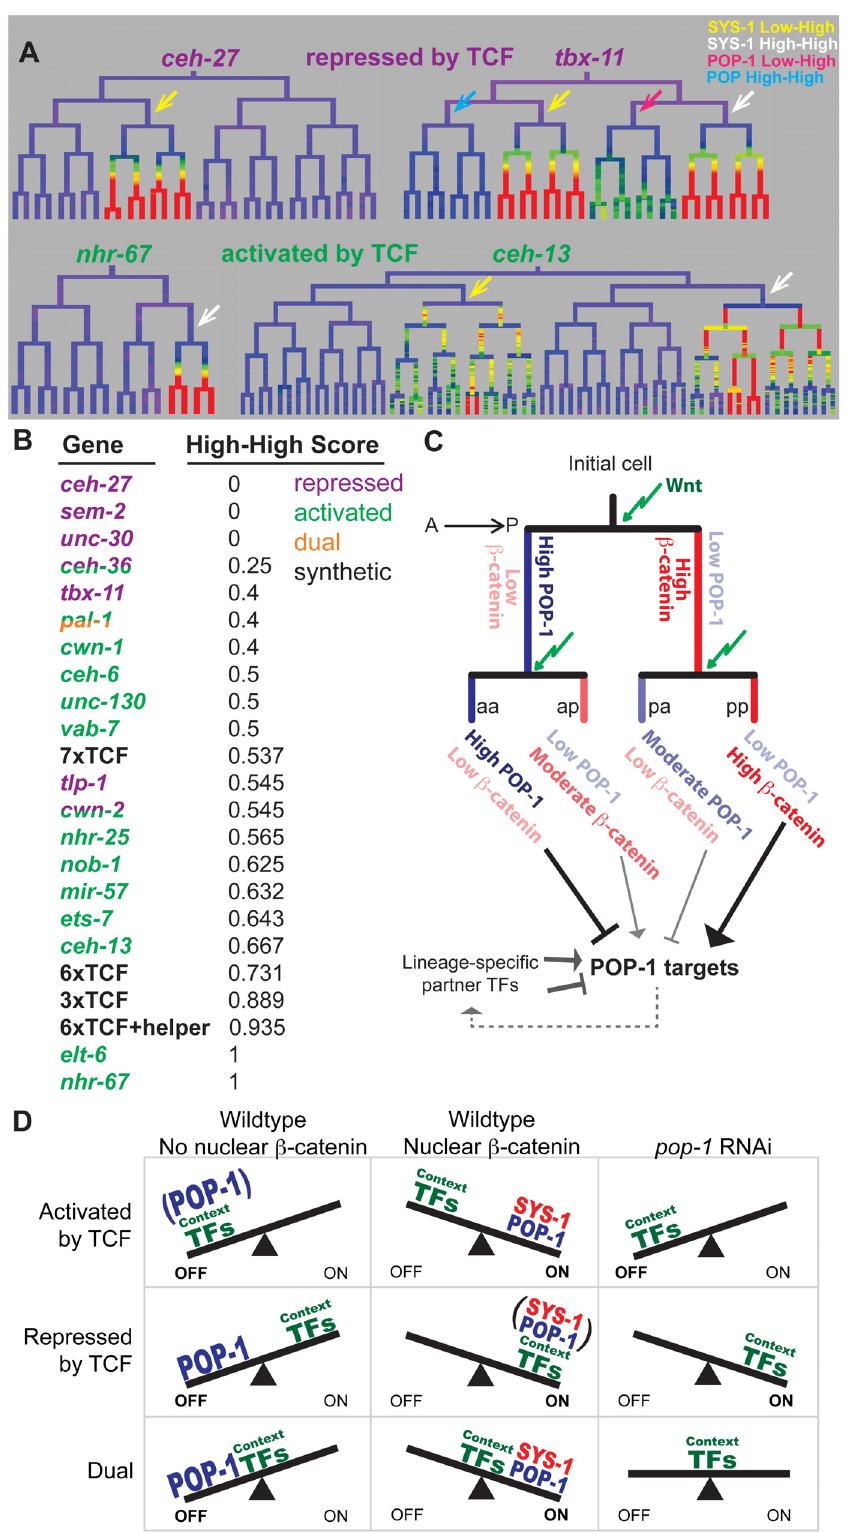
Fig 7. Updated model for TCF-mediated lineage diversification. A) Examples of wild-type expression patterns for genes that require TCF primarily for repression or activation. Repressed genes have